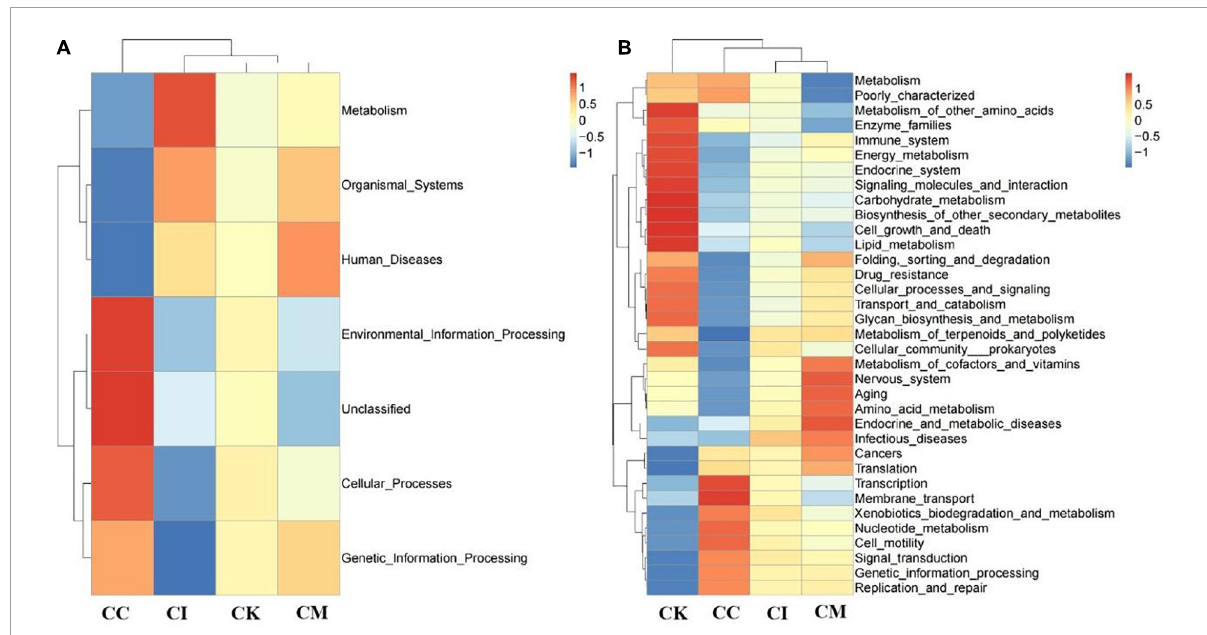
FIGURE8 Effect of koumiss on the microbiota functional profile in mice chronically infected with T. gondii . (A) Level 1. (B) Level 2. CC: no T. gondii + PBS; CI: 3 T. gondii cysts + PBS; CK: 3 T. gondii cysts + koumiss; CM: 3 T. gondii cysts + mare’s milk. All data are expressed as mean ±